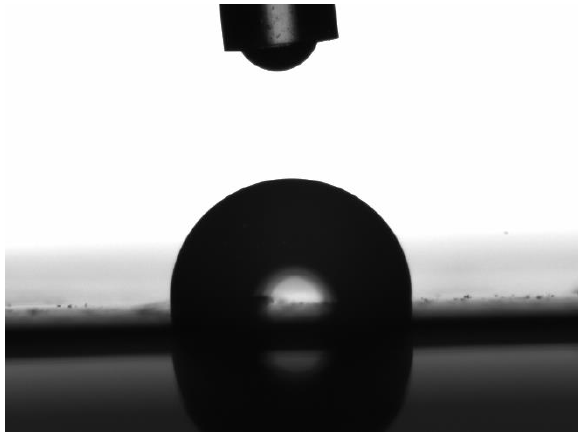
Figure 2. Captured image from dynamic contact angle measurement4.